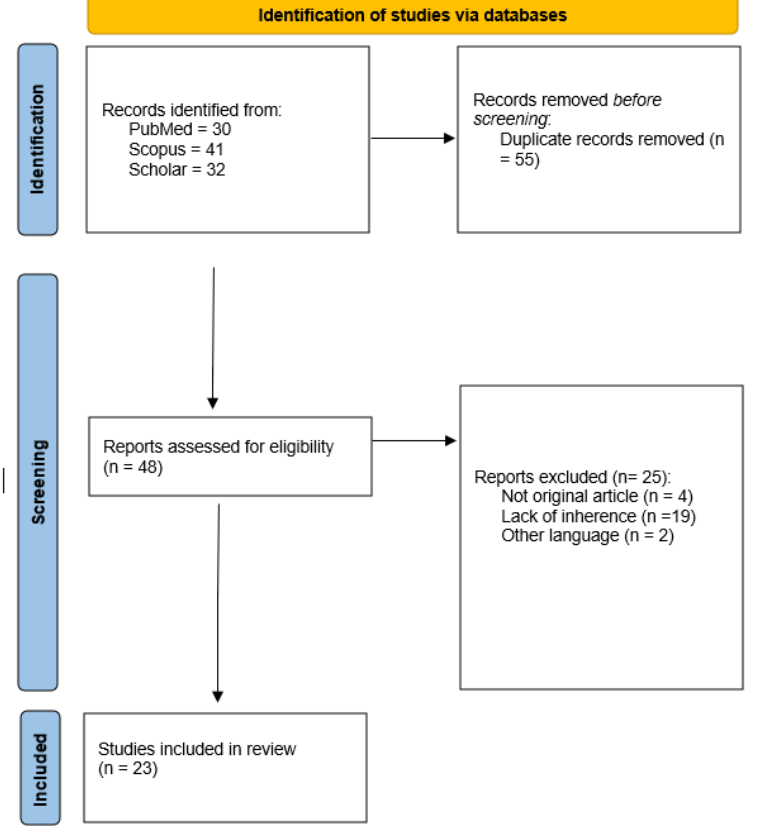
Figure 1. Study selection process flowchart according to the PRISMA Statement 2020 [12].